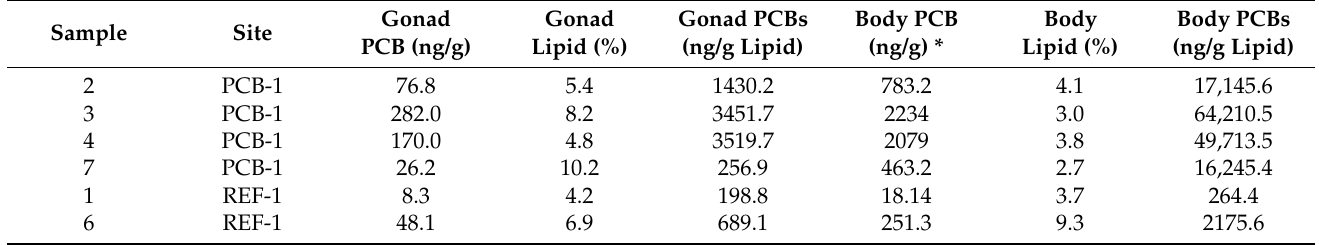
Table 6. PCB concentrations and lipid values for damselfish gonads and body.